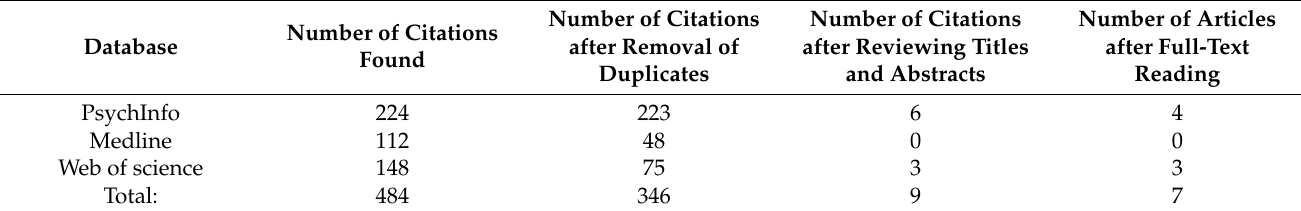
Table 1. Number of citations from the